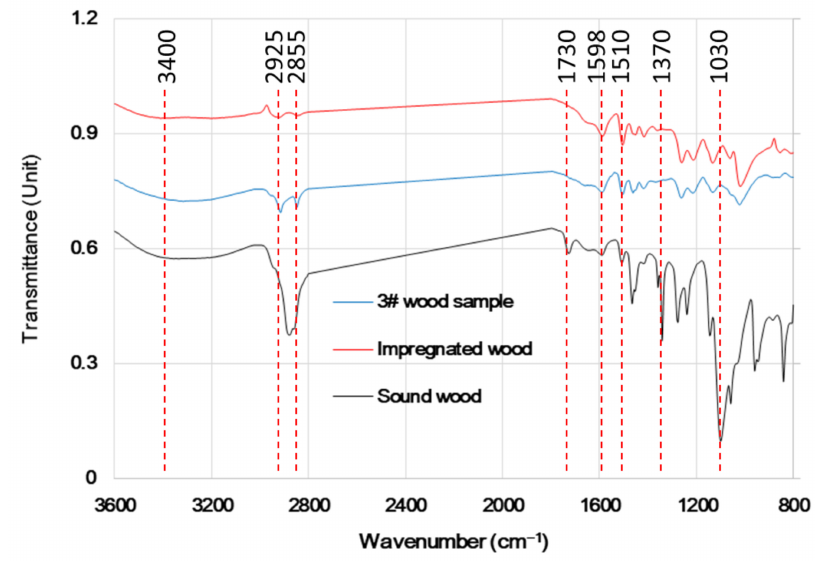
Figure 6. FTIR spectra of the specimens immersed in PEG4000 and those un-impregnated.